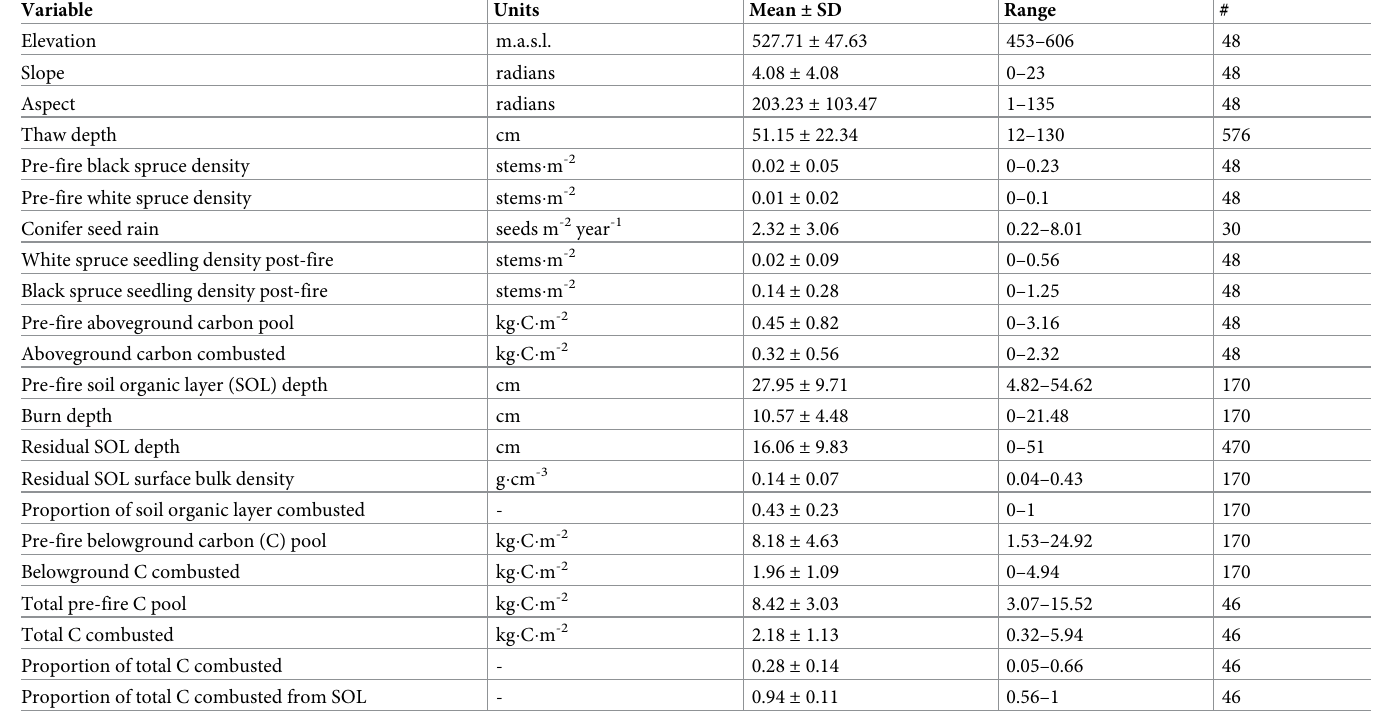
Table 1. Summary of measured and estimated burned plot